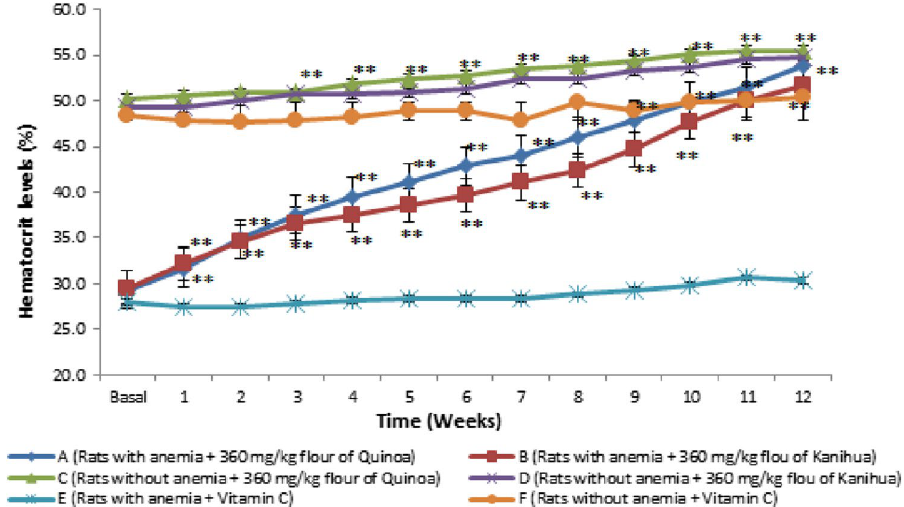
were administered 360 mg/kg Quinoa flour Negra Collana variety (Group C), Rats without anemia that were administered 360 mg/ kg Kanihua flour Ramis variety (Group D), Rats with anemia that were administered Vitamin C (Group E), Rats without anemia that were administered Vitamin C (Group F). Each point represents the mean ± SEM of three rats, * p ≤ 0.05, ** p ≤ 0.01